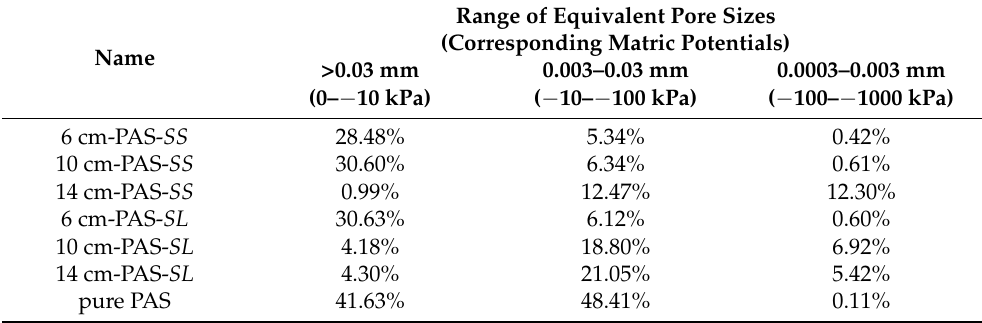
Table 5. Equivalent pore volume ratio of